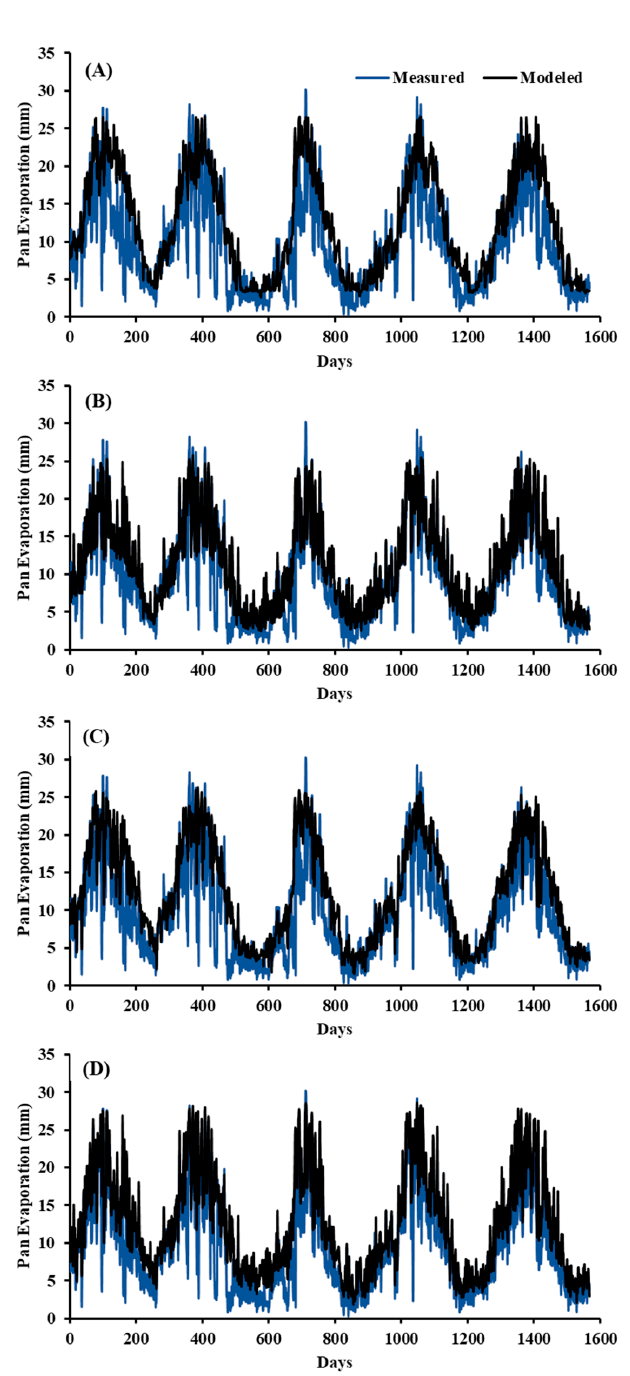
Figure 7. Modeled and measured pan evaporation time series (validation period) for ( A ) Model 1 (T), ( B ) Model 2 (T, W), ( C ) Model 3 (T, RH), and ( D ) Model 4 (T, W, RH). T: average daily temperature; RH: average relative humidity; W: average wind speed.